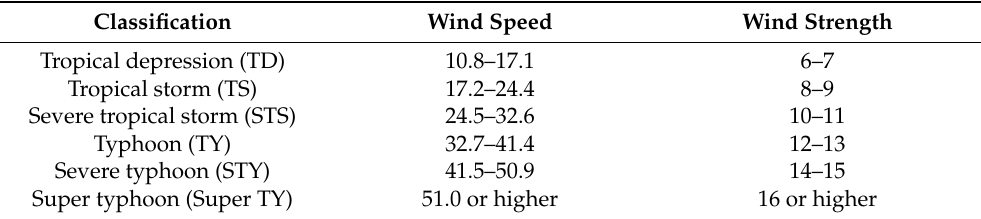
Table 1. Classification of tropical